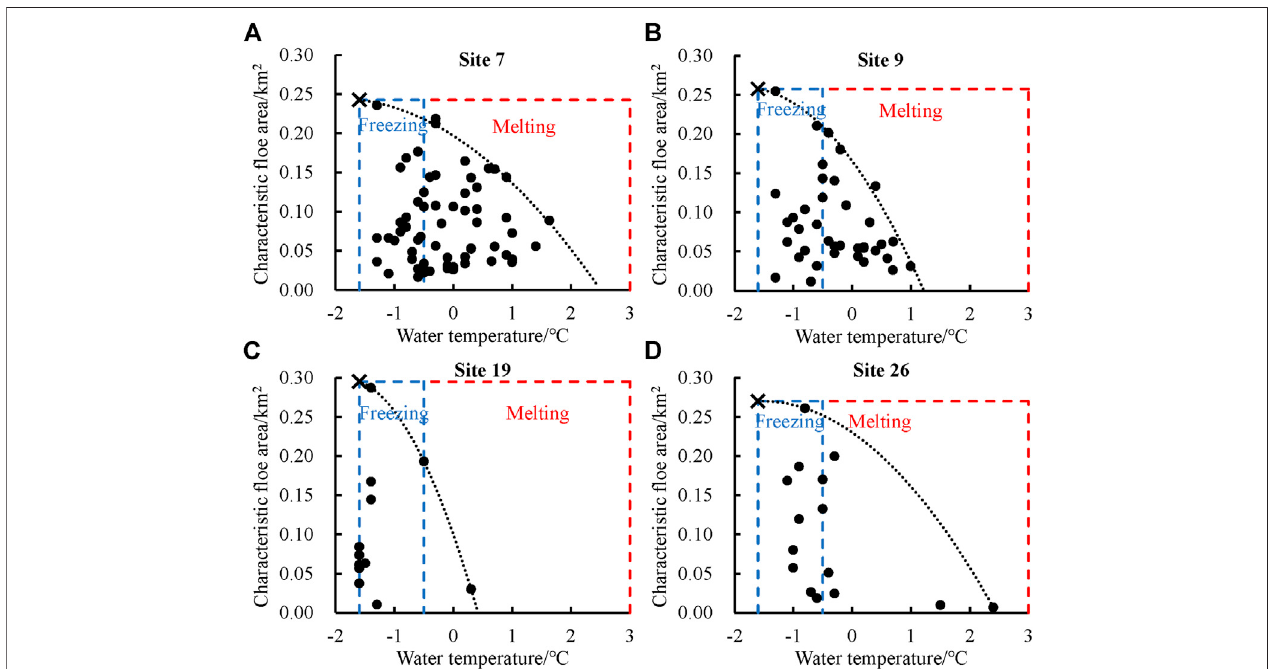
FIGURE7| Characteristic fl oeareaversuswatertemperaturesatthefoursites( (A) site7intheLiaodongBay, (B) site9intheLiaodongBay, (C) site19intheBohai Bay, and (D) site 26 in the Laizhou Bay). The black dotted line is the upper envelope curve of data points. The blue and red frame areas represent drift ice ’ s freezing and melting cases. The value of the black cross is the design fl oe